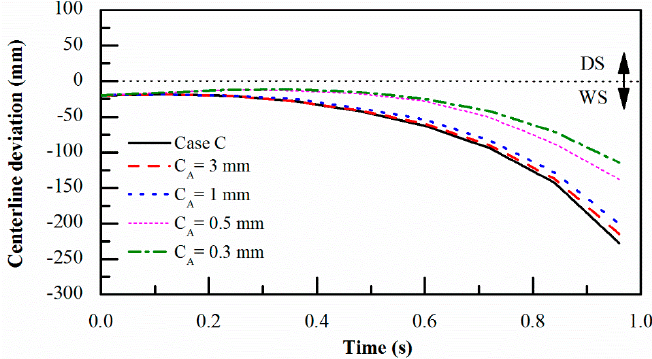
Figure 13. The effect of the superimposed axial clearances on correcting the centerline deviation. Figure 13. The e ff ect of the superimposed axial clearances on correcting the centerline